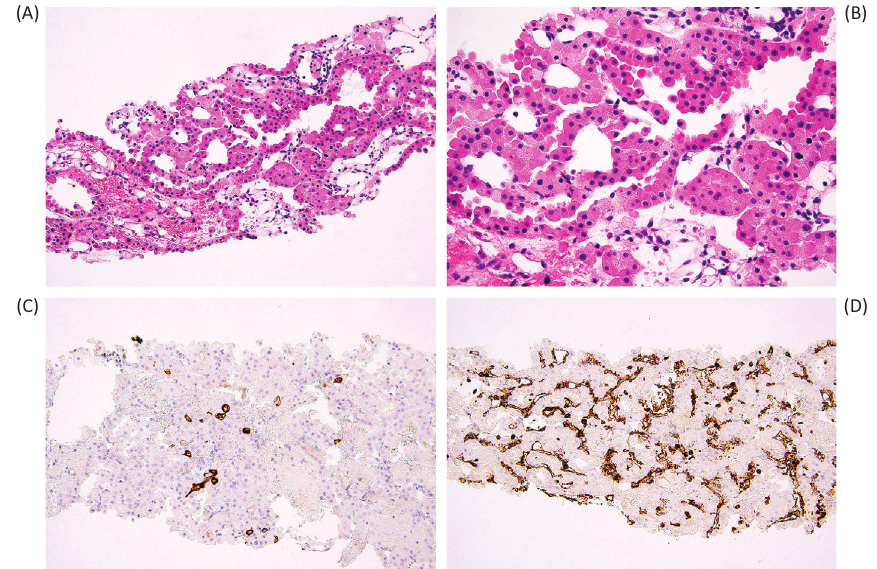
Figure 3. Core needle biopsy of oncocytoma (A) demonstrates tubular structures lined by homogeneous eosinophilic cells with round, regular nuclei (B). The typical immunohistochemical staining pattern includes rare CK7-positive cells (C) and negative vimentin staining (D), the latter highlighting only the